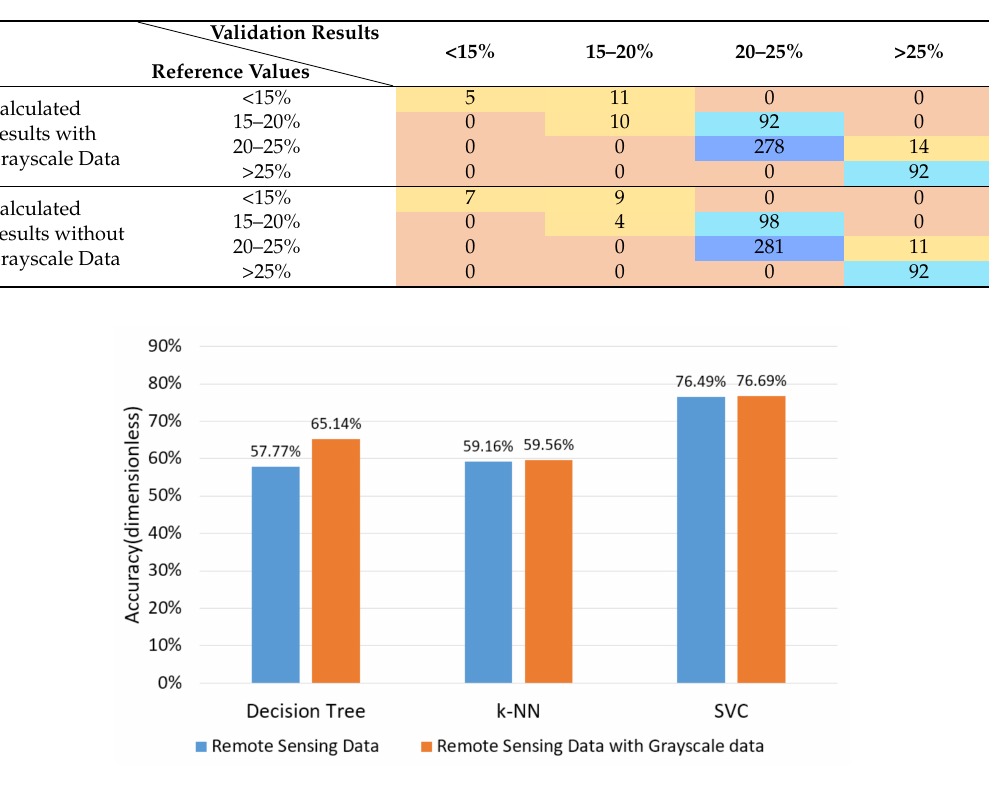
Figure 5. The accuracy of the calculated results with different algorithms and training